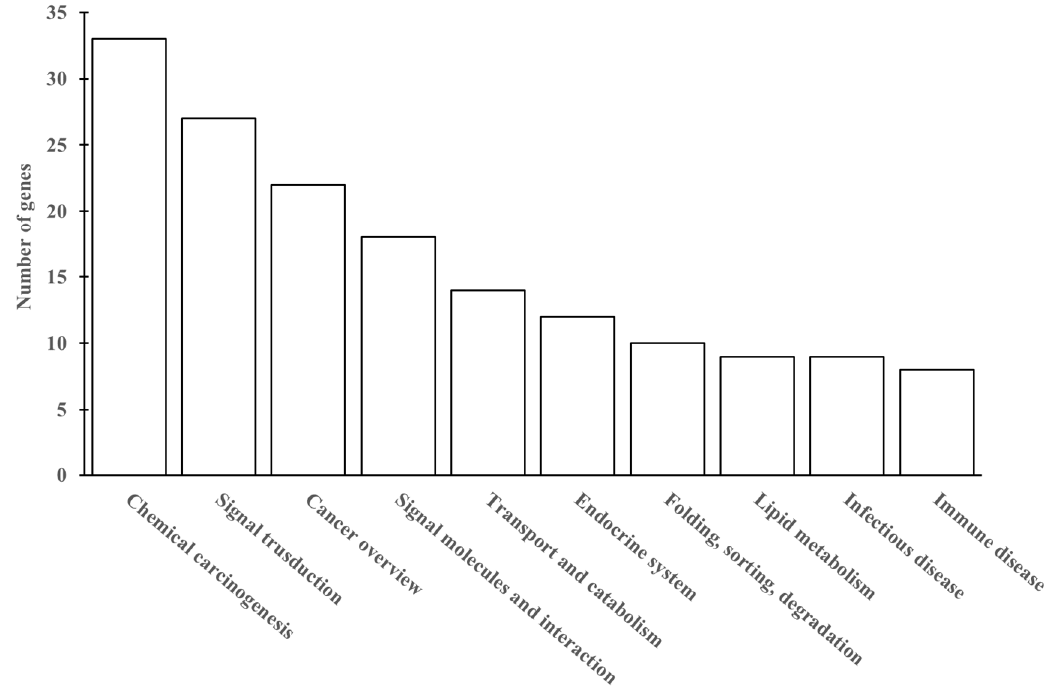
Figure 11. Kyoto Encyclopedia of Genes and Genomes (KEGG) database enrichment classification of differentially expressed genes (DEGs).